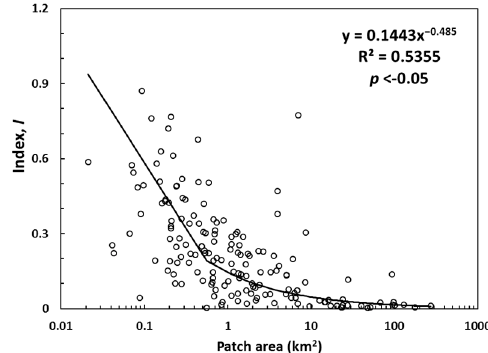
Figure 6. Values of index I for all patches vs. patch areas.